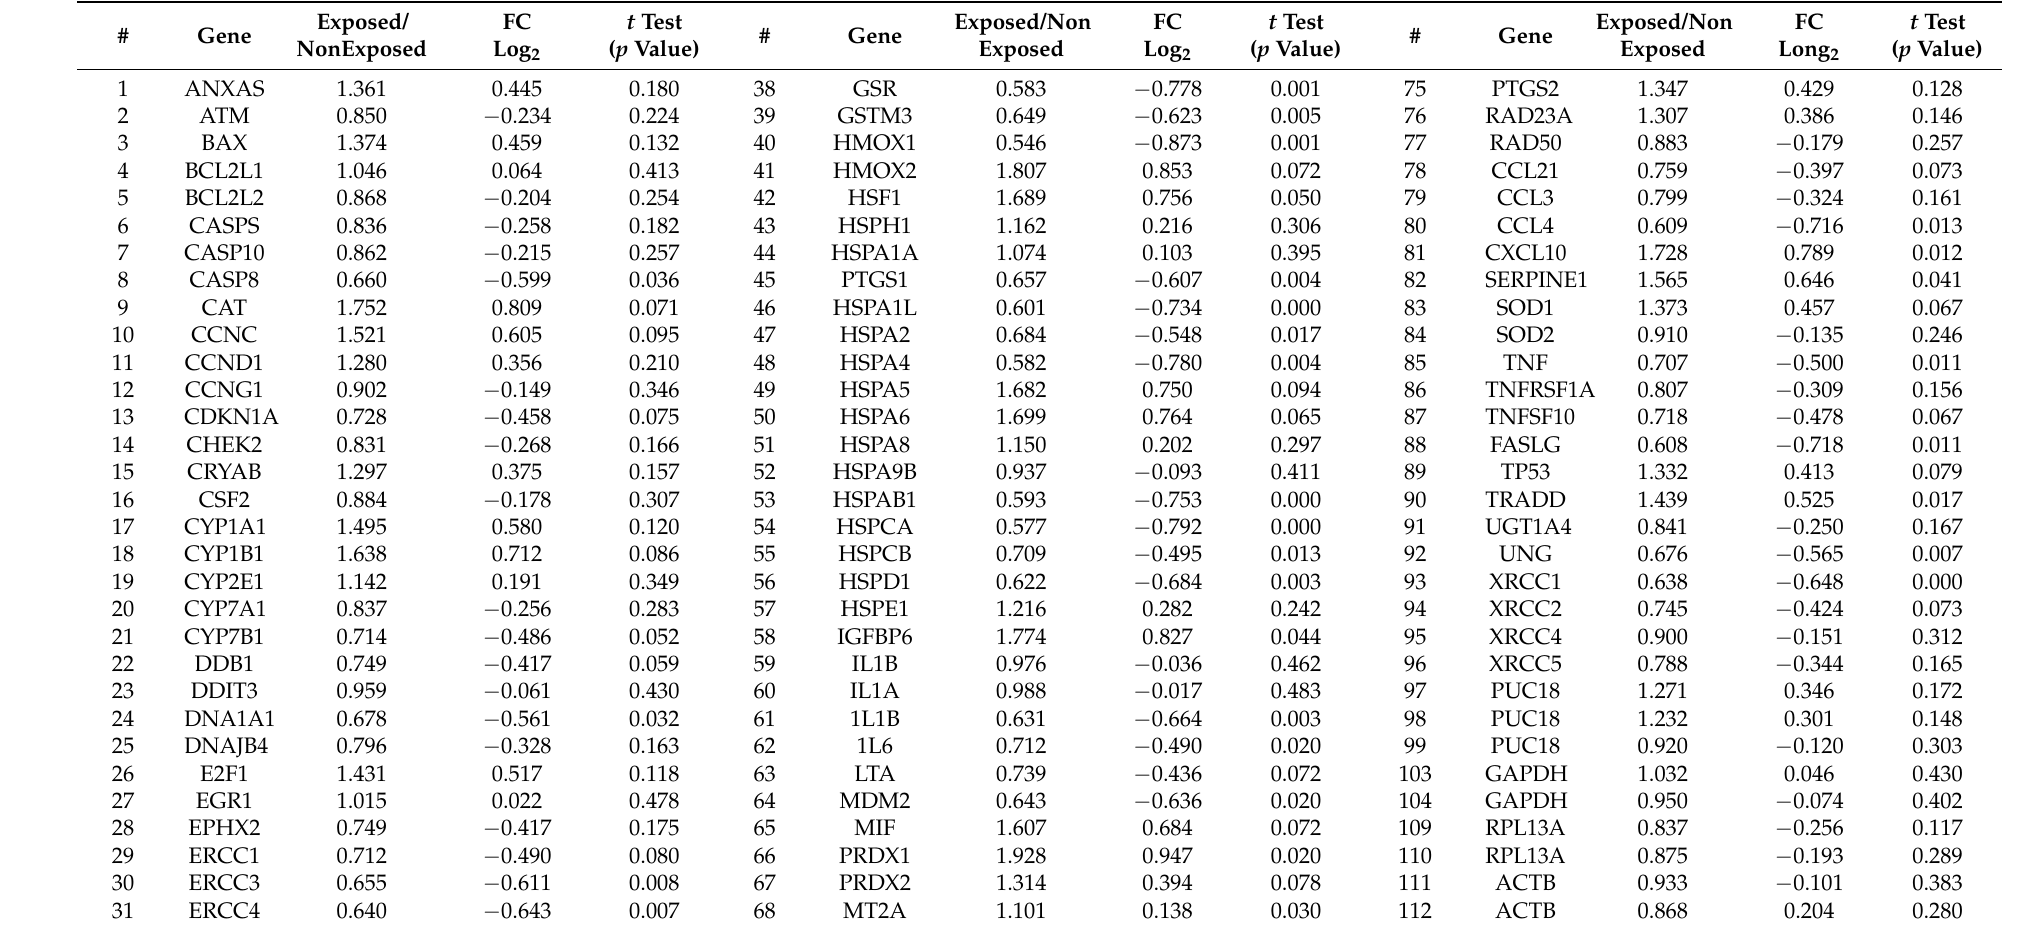
Table 2. Stress and Toxicity Gene expression changes in lead exposure workers and p values by t